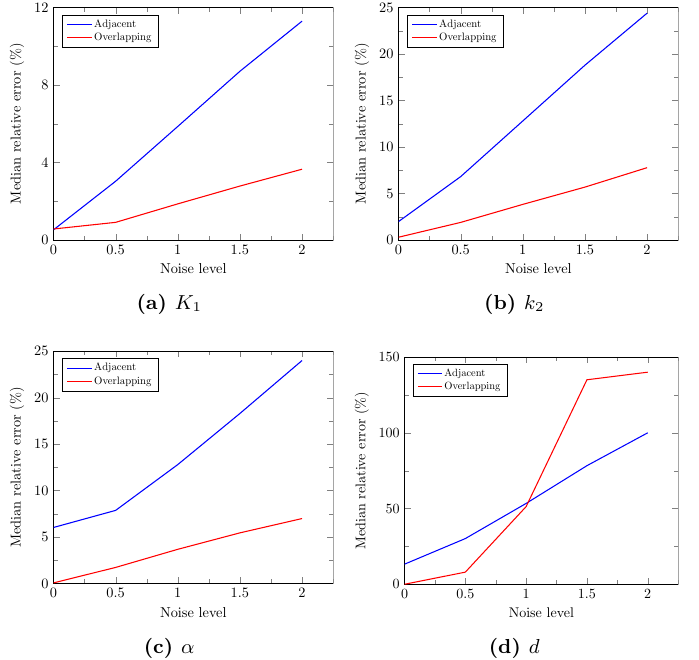
Figure A2. Median relative errors on the fitted 1TCM parameter values computed over the 10,000 simulated TACs for each level of noise and both framing strategies (blue curve: adjacent, red curve: